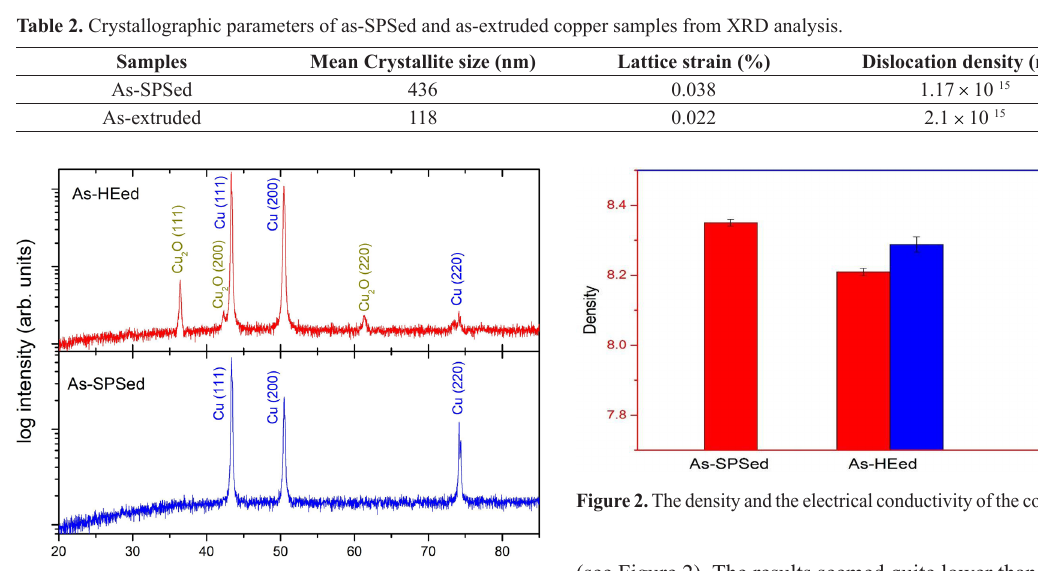
Figure 1. XRD profiles (in logarithmical scale) of as-SPSed and as-extruded samples.